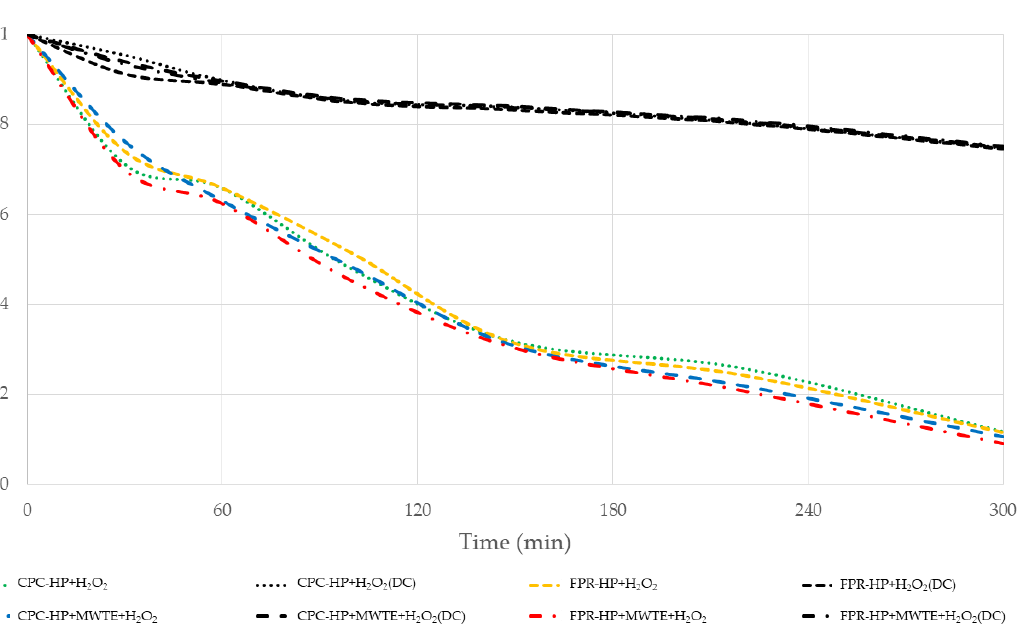
Figure 7. As III heterogeneous photocatalytic (HP) oxidation experiments carried out both in CPC and FPR, H 2 O 2 added, and with and without MWTE spike. Experiments performed in the dark as control experiments (DC) are included as well.